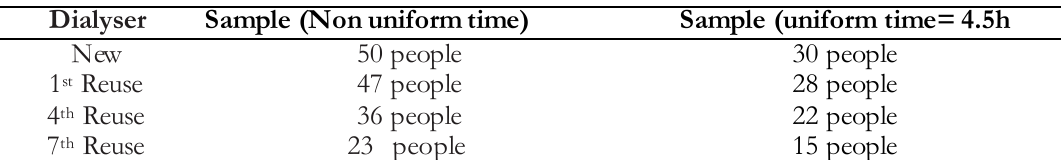
Table I. Number of sample